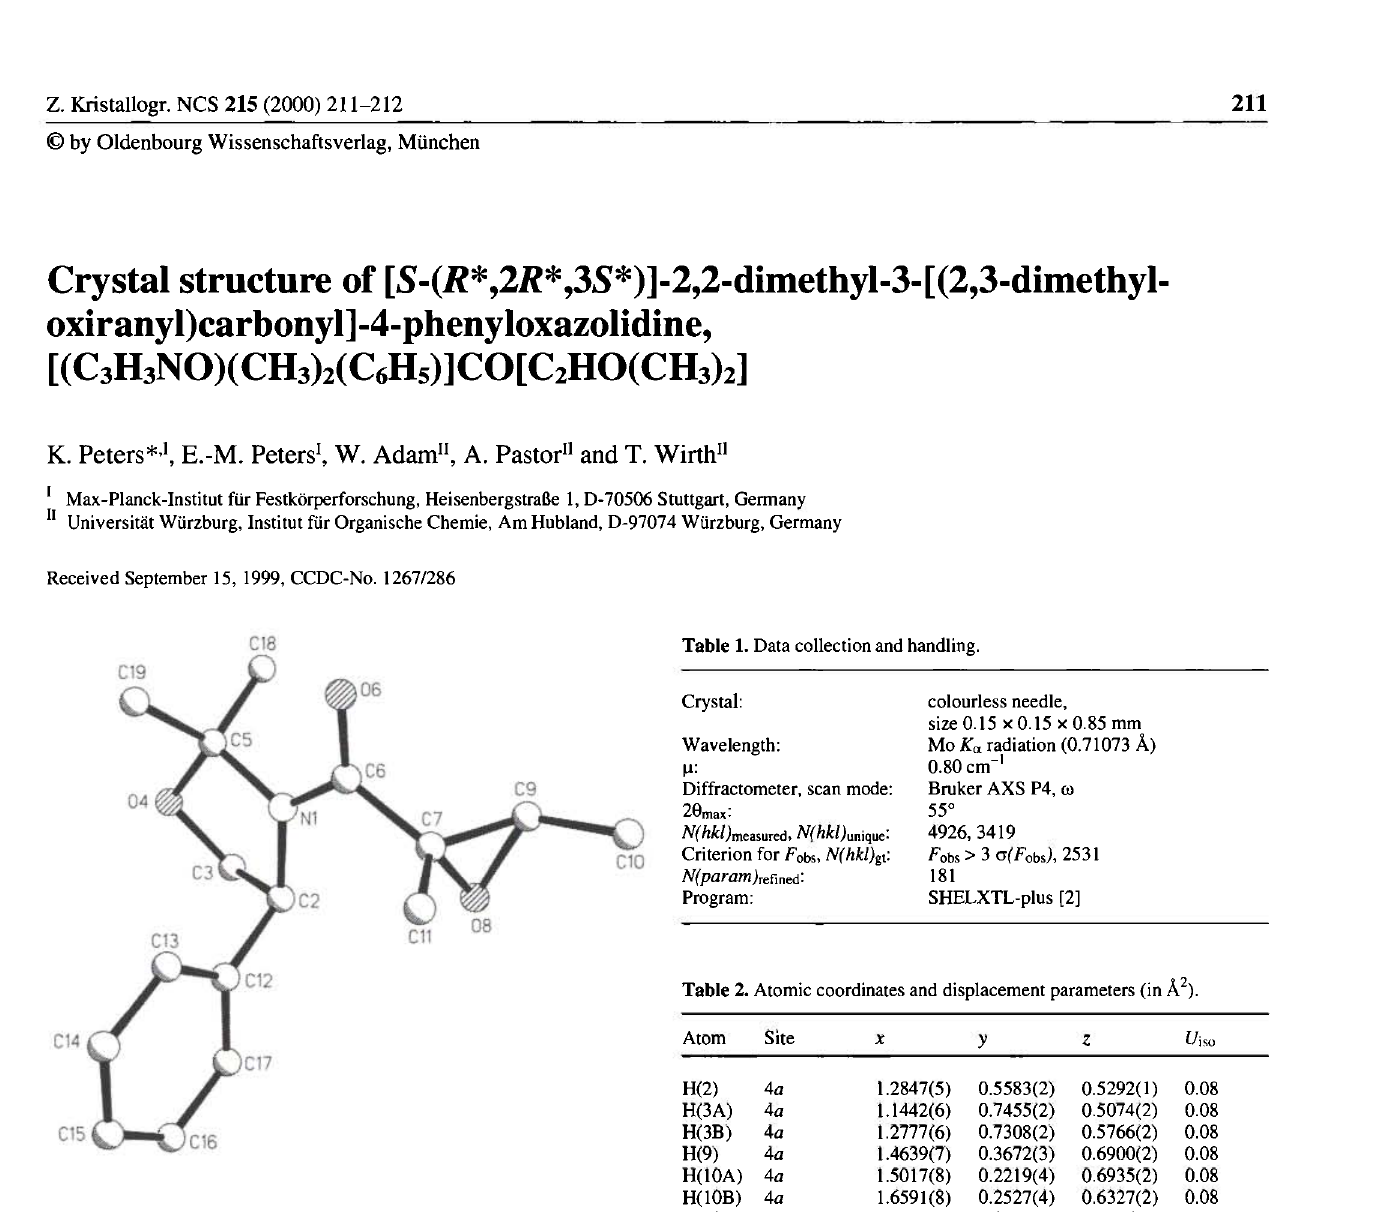
Table 2. Atomic coordinates and displacement parameters (in A 2 ).